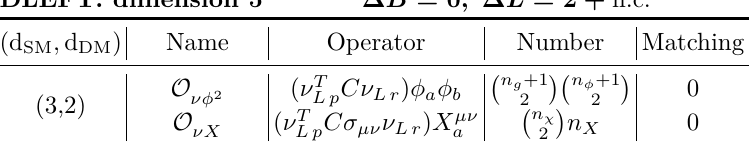
Table 30 . Dimension-five ∆ B = 0 , ∆ L = 2 operators in DLEFT. The first column gives the dimensions of the SM and DM part of the operator, the fourth column is the number of operators, and the fifth column is the additional matching contribution at the EW scale.